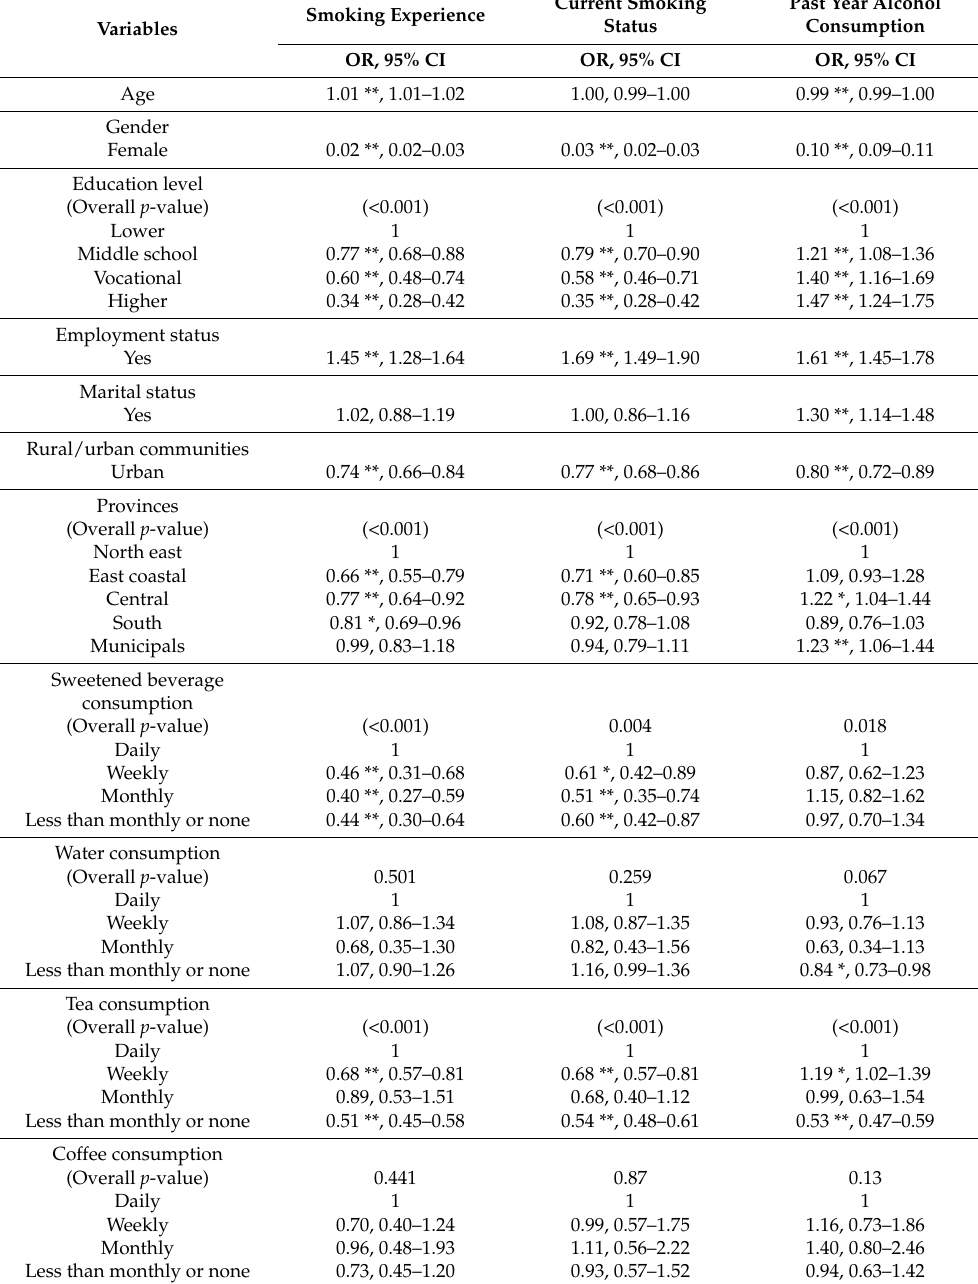
Table 2. Odds ratios (OR) and 95 percent confidence intervals (95% CI): Associations among beverage intake frequencies, smoking, and alcohol consumption behaviors adjusted with all covariates. Data source: China Health and Nutrition Survey, 2011